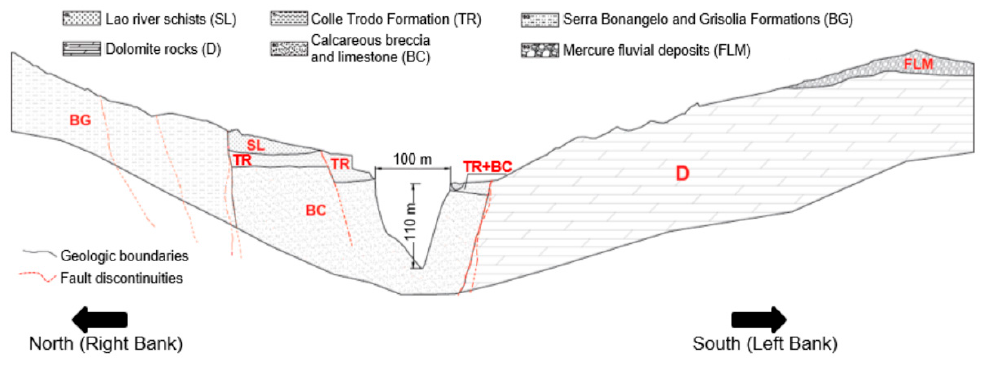
Figure 4. Geologic model of the Lao River Valley (modified from [17]).